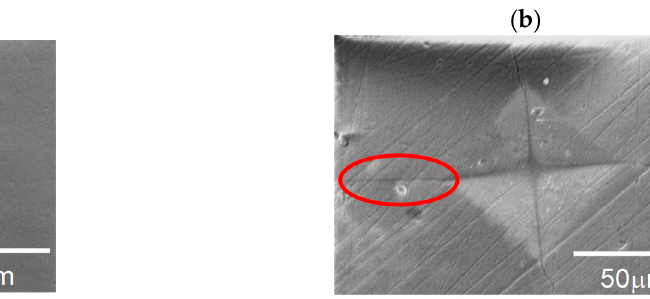
Figure 18. Vickers hardness indentation impression on ZrO 2 -rich surfaces of the FGMs with PCA (20%) before ( a ) and after ( b ) cyclic thermal shock tests.